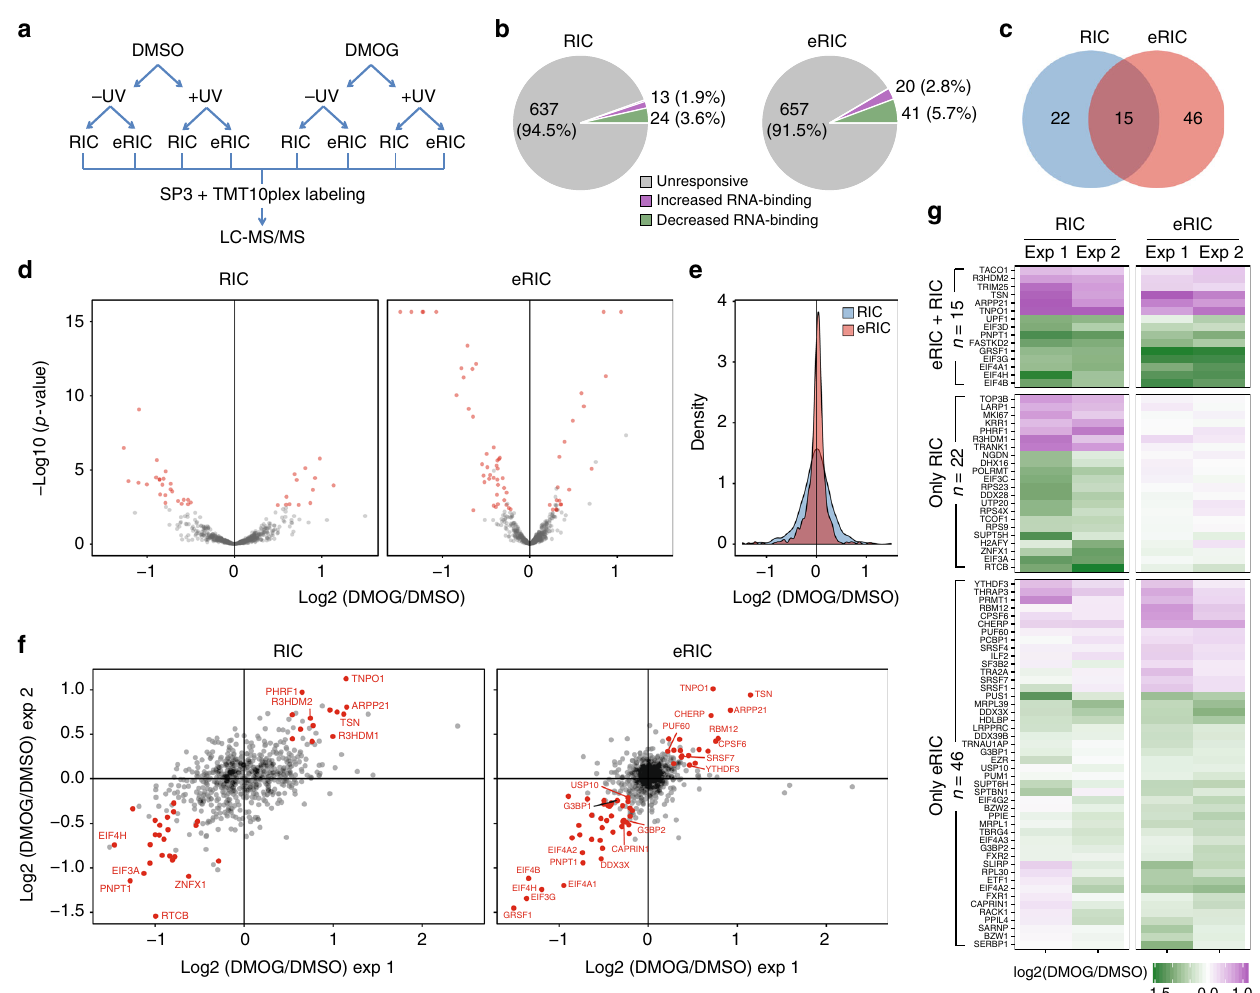
Fig. 5 Superior performance of eRIC in comparative analyses of RBP responses. a Experimental design: Jurkat cells were incubated for 6 h with 0.5 mM DMOG or the vehicle DMSO. After irradiation, cells were lysed and lysates equally split for eRIC or RIC analyses. n = 2 independent experiments. b Pie charts summarizing the response of the RNA-bound proteomes to DMOG treatment identi fi ed by eRIC (right) or RIC (left). The number and percentage of proteins displaying constant (gray), increased (green), or decreased (violet) RNA association upon DMOG is shown. c Venn diagram comparing the number of DMOG-responsive RBPs identi fi ed by each method. d Volcano plots displaying the p values ( y axis) and the log2-fold change (FC) in DMOG- versus DMSO -treated and irradiated samples ( x axis) of the proteins detected by eRIC (right) and RIC (left). Proteins with FDR < 0.05 (moderated t test) and consistent FC of at least 10% in each replicate were considered as hits and are depicted in red. e Density of log2-FC in DMOG- over vehicle-treated and irradiated samples of the proteins identi fi ed by eRIC (red) and RIC (blue). Note the lower signal dispersion of the RBPs recovered by eRIC. f Scatter plots of detected proteins comparing the log2 ratios (DMOG/vehicle) of two independent experiments (exp 1/2). g Heat map showing the protein log2 ratios (DMOG/vehicle) of eRIC/RIC hits. Hits were divided according to their occurrence in eRIC and/or RIC and clustered. Upper: eRIC/RIC common hits, middle and bottom: RIC and eRIC exclusive hits,